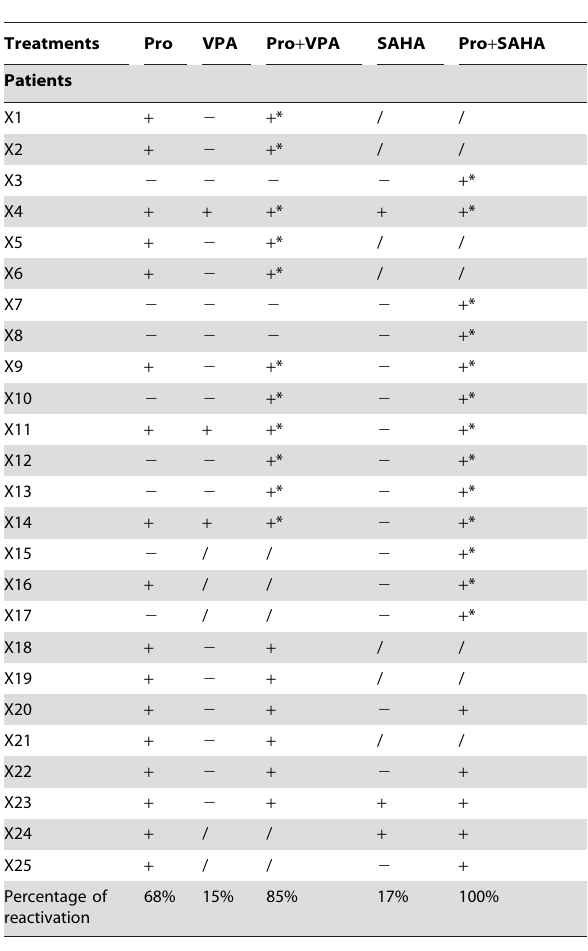
Table 2. Reactivation profiles observed in CD8 + -depleted PBMC cultures from patients X1 to X25.